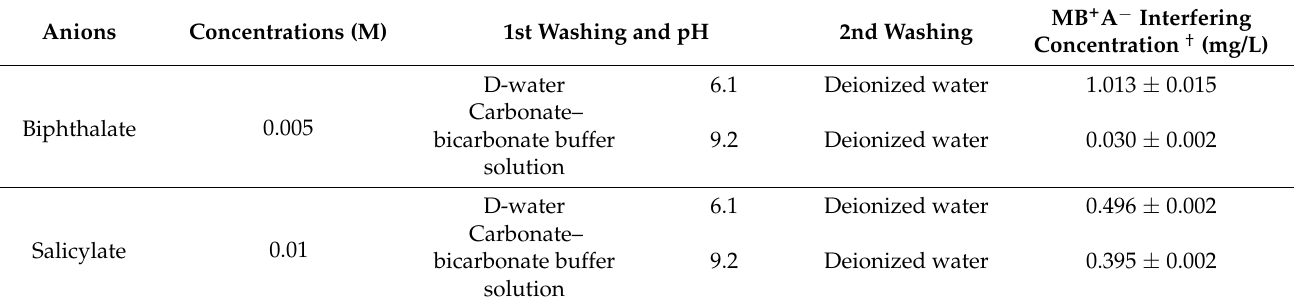
Table 6. Effects of washing with carbonate–bicarbonate buffer solution on the interferences by biphthalate and